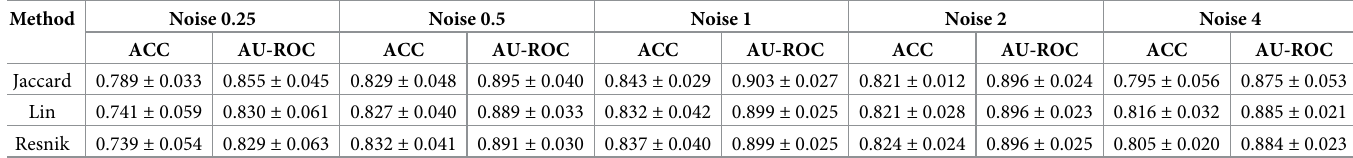
Table 4. Model performance of semantic similarity measures across levels of simulated phenotypic sparsity and noise (see Fig 2). Abbreviations: ACC–accuracy; AU-ROC–area under the receiver operator characteristics curve.